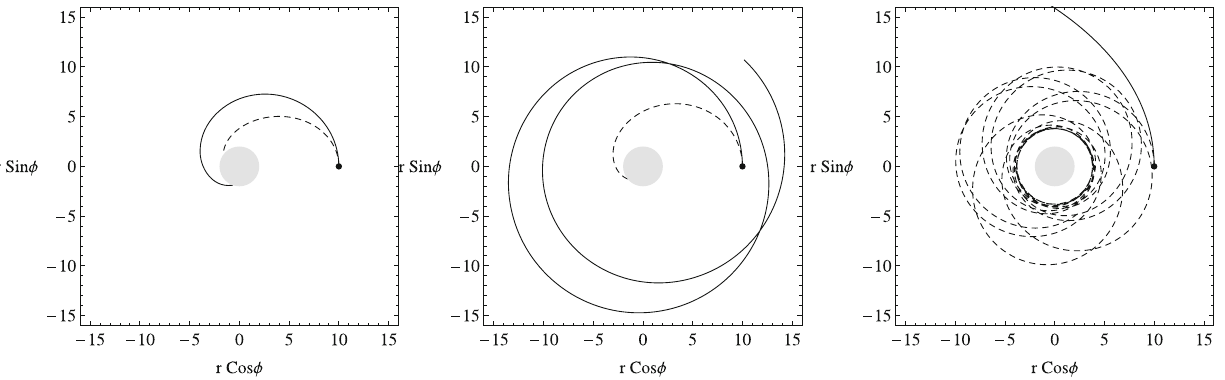
ticle case, i.e. q / m = 0. Middle/right panels: V eff is plotted for various combinationsofchargedparticleparameters q / m forthefixedmagnetic field parameter B = 0 . 1